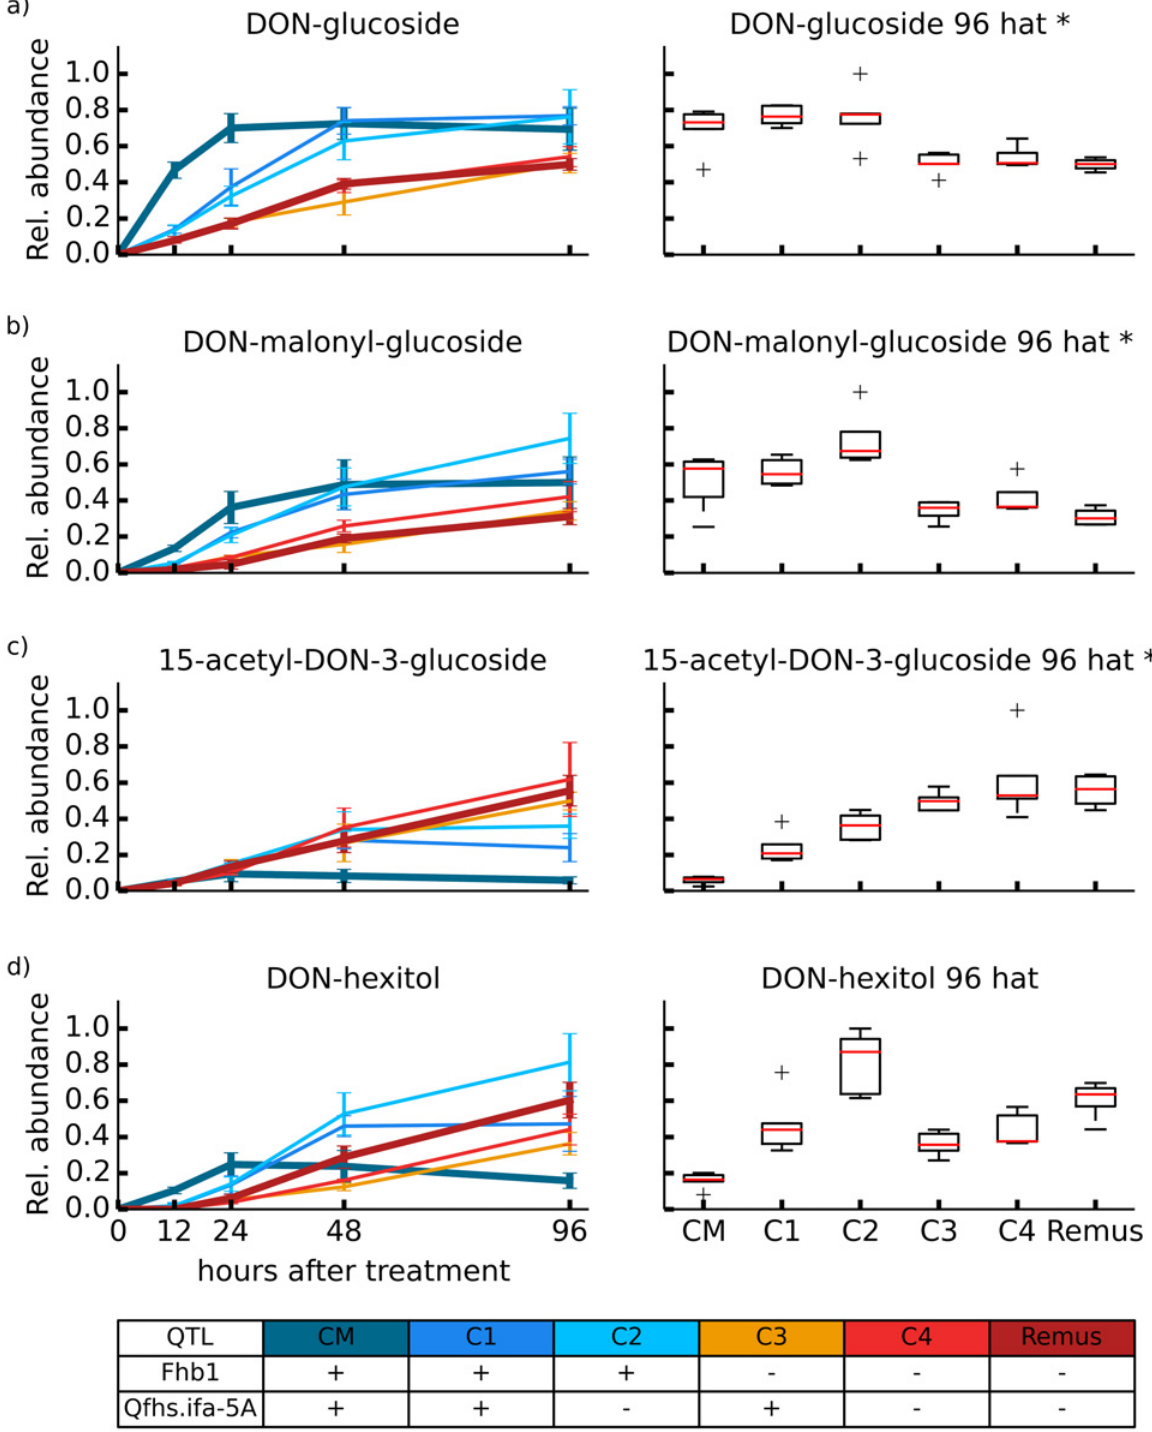
Fig 4. Detoxification of DON via glucosylation/sugar alcohol. Glucose/sugar alcohol related detoxification of DON. Relative formation rates for the biotransformation products DON-glucoside (a), DON-malonyl-glucoside (b), 15-acetyl-DON-3-glucoside (c) and DON-hexitol (d). Additionally, for each biotransformation product boxplots for relative metabolite abundance observed 96 h after DON treatment were generated. * Significantly differing biotransformation product levels between wheat lines with and without resistance QTL Fhb1 based on a non-paired t-test (5% global significance threshold).